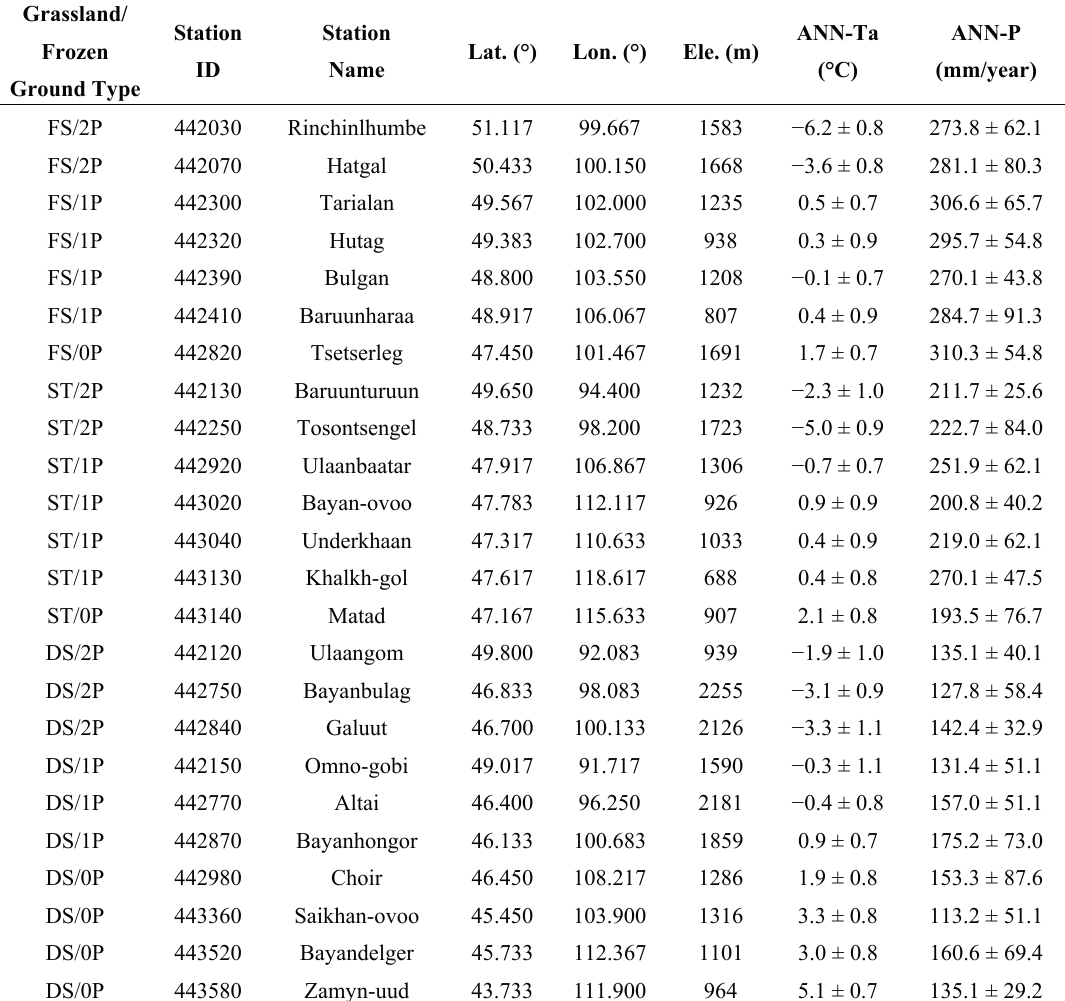
Table 1. Description of meteorological stations, including ID, name, geolocation (Lat.: latitude; Lon.: longitude; Ele.: elevation), annual mean air temperature (ANN-Ta), annual total precipitation (ANN-P) with standard deviations calculated during the period of 2000–2009, and grassland/frozen ground types (FS: forest steppe; ST: steppe; DS: desert